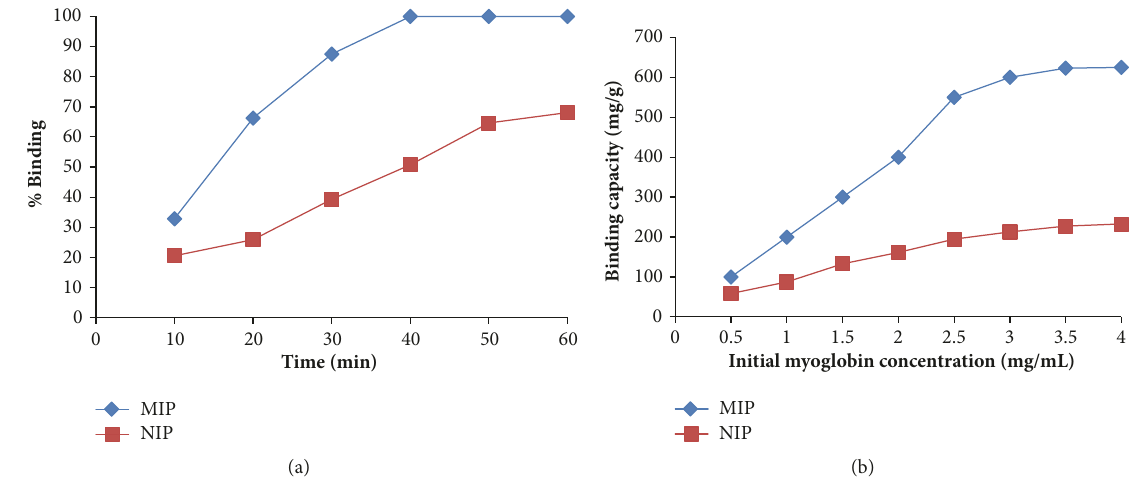
displayed high binding behaviour towards myoglobin at higher myoglobin concentrations in the range from 0.5 to −1 . After saturation value which is 3.5 mgmL 3.5 mgmL